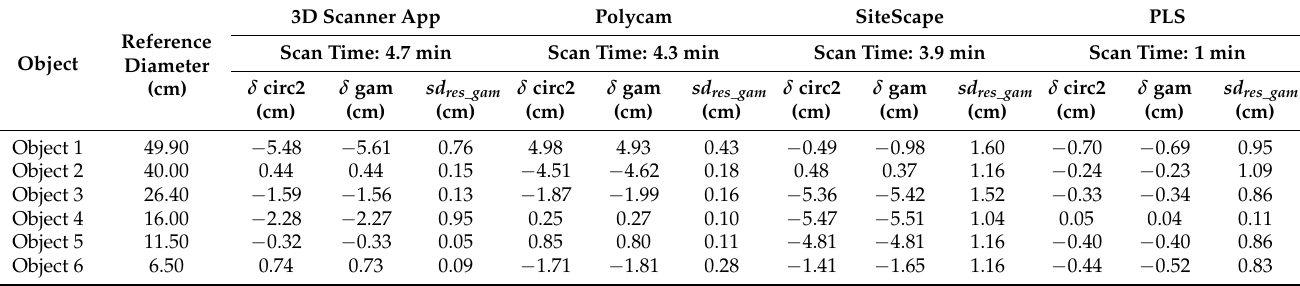
Table 3. Evaluation of iPad and PLS on reference